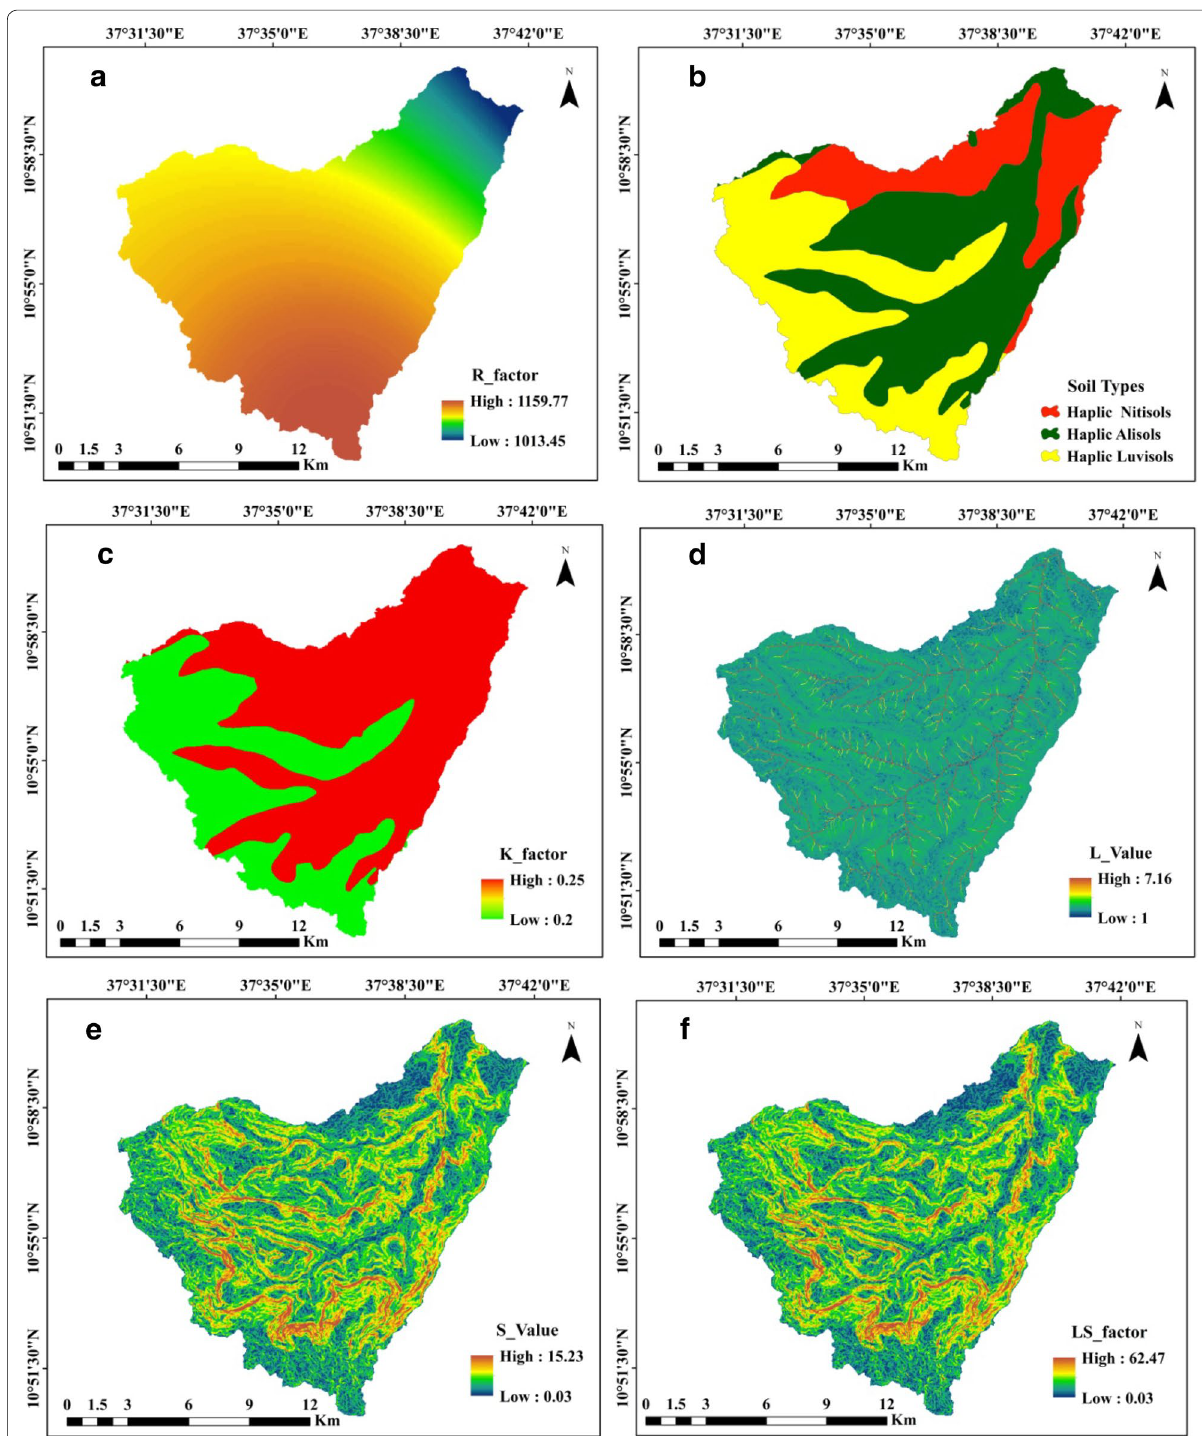
Fig. 2 Map of Gumara watershed showing a R-factor, b soil types, c K-factor, d slope length value, e slope steepness value and f LS-factor